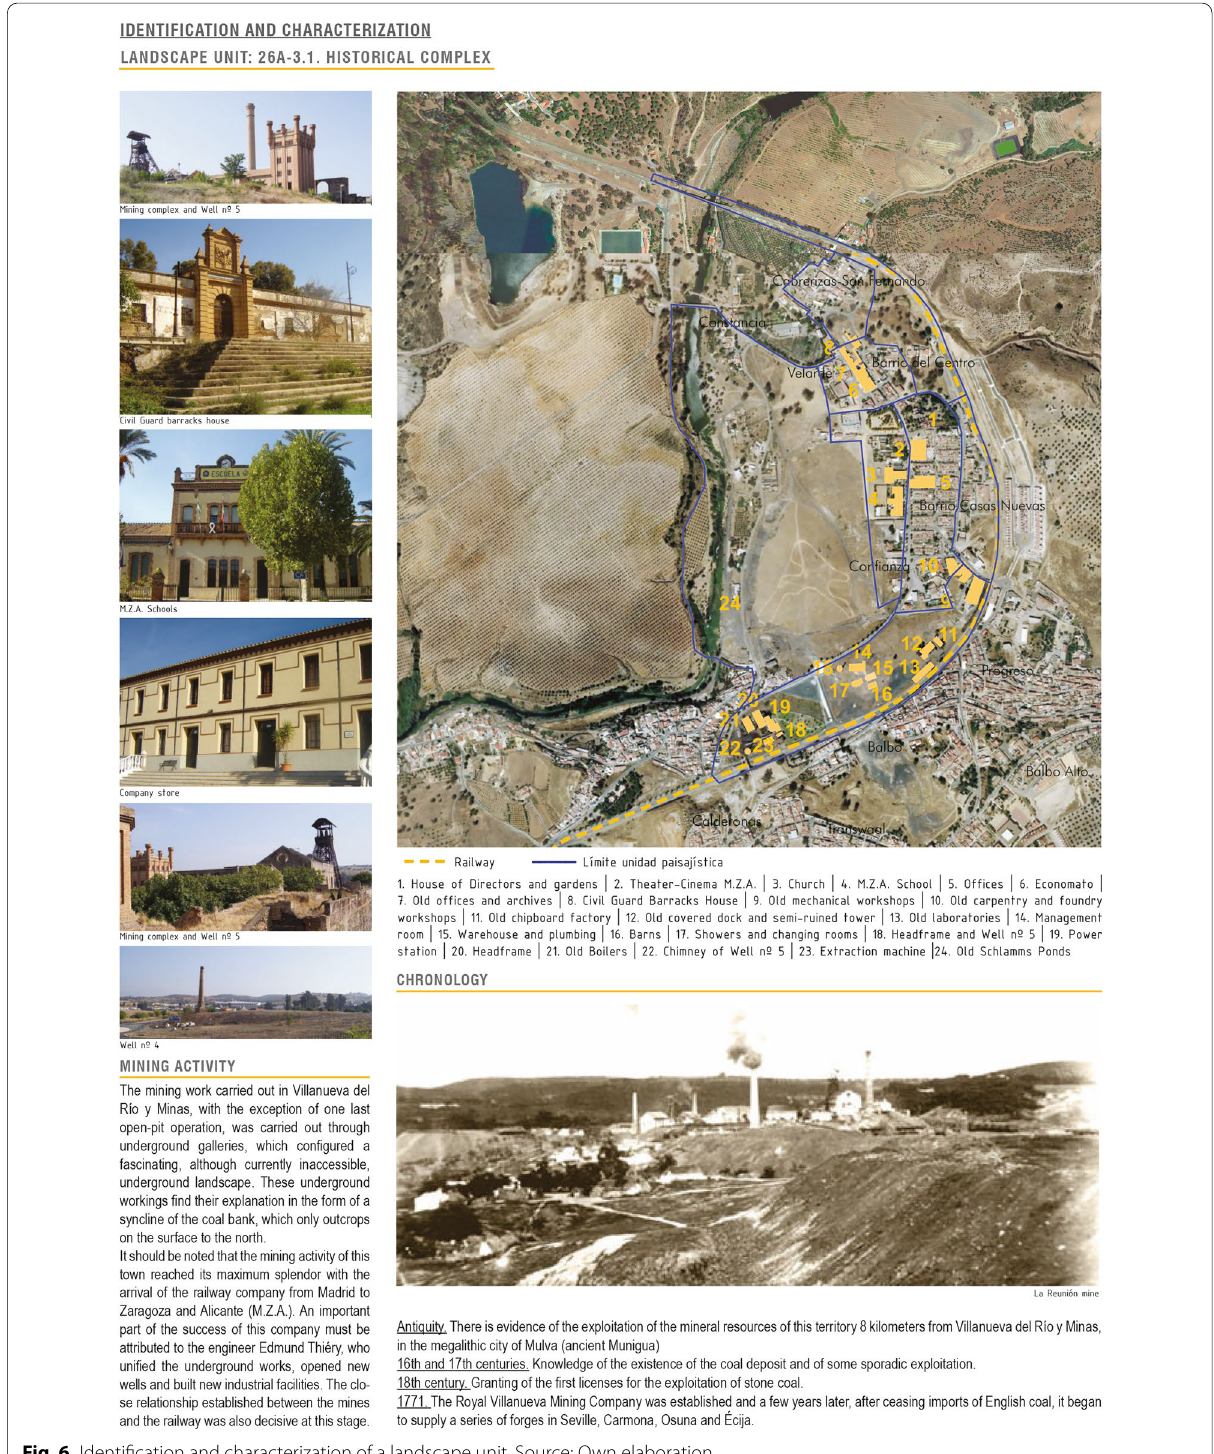
Fig. 6 Identification and characterization of a landscape unit. Source: Own